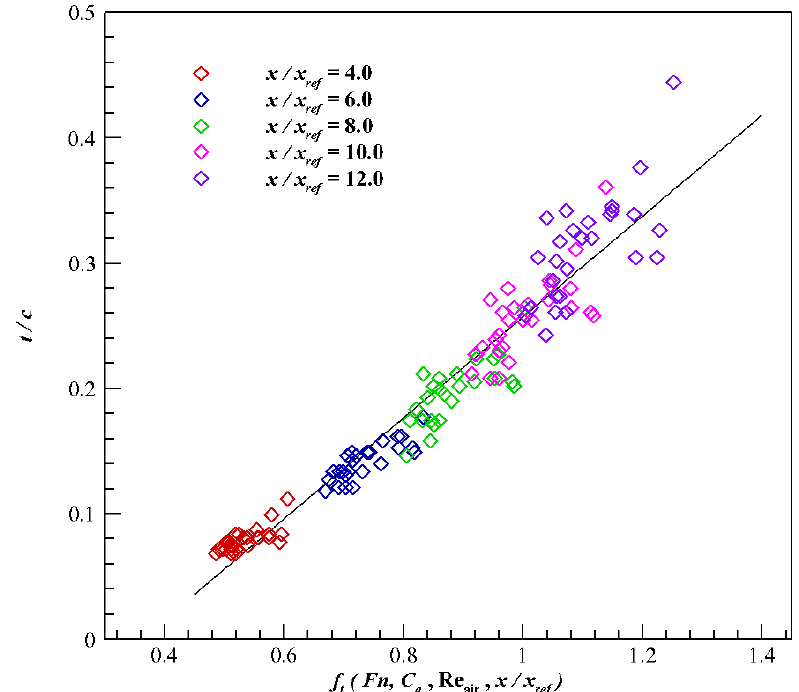
Figure 20. The non-dimensional jet thickness, t / c , was plotted against f t , which was a function of Froude number, Fn , and air injection coefficient, C q , Reynolds number, Re air , and non-dimensional streamwise distance, x / x ref , with the colors in red, blue, green, magenta and violet representing x / x ref = 4,6,8,10 and 12, respectively. The R 2 value for the linear curve fit was